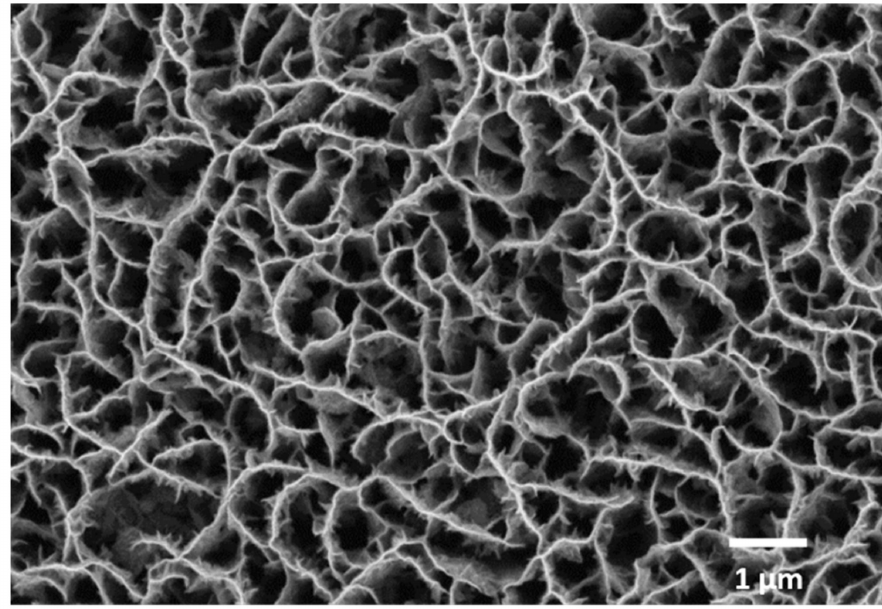
Figure 2. Top-view SEM image of a CNW donor prior to laser-induced forward transfer.